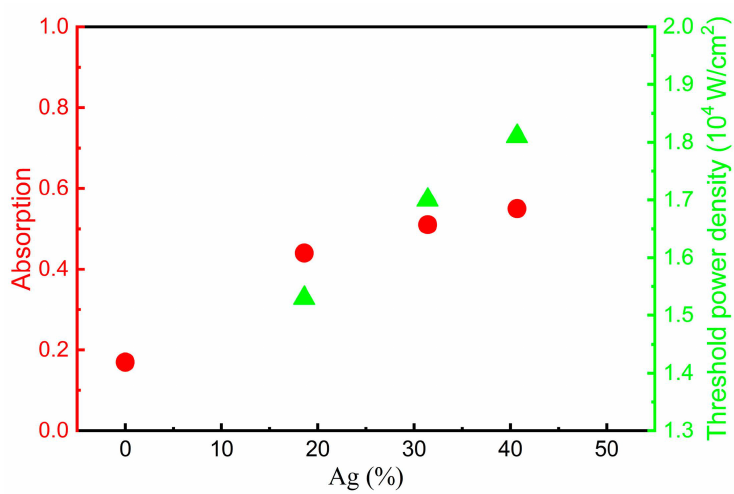
Figure 5. The absorption and the critical power density of the samples doped with different silver concentrations. The red circles and green triangles indicates the absorption and threshold power density,